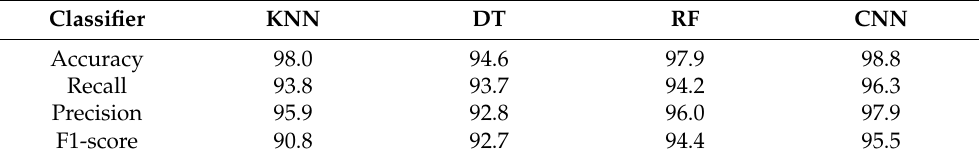
Table 3. Phase 1: Continuous authentication results for Scenario A: single mouse movement action.